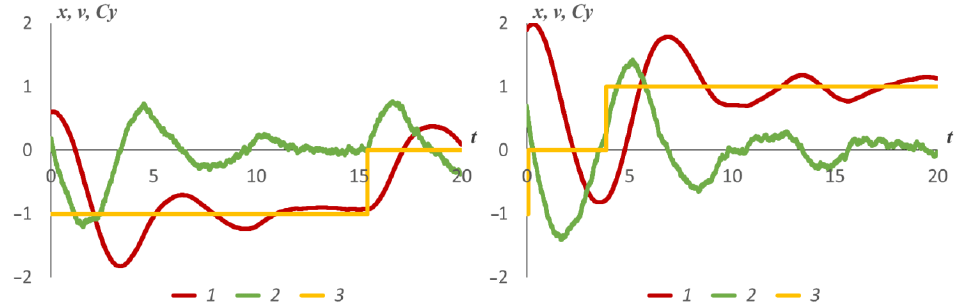
Figure 2. Typical state trajectory of the model with the “slow varying” CTMC drift: 1—coordinate x t ; 2—velocity v t ; 3—drift Cy t .